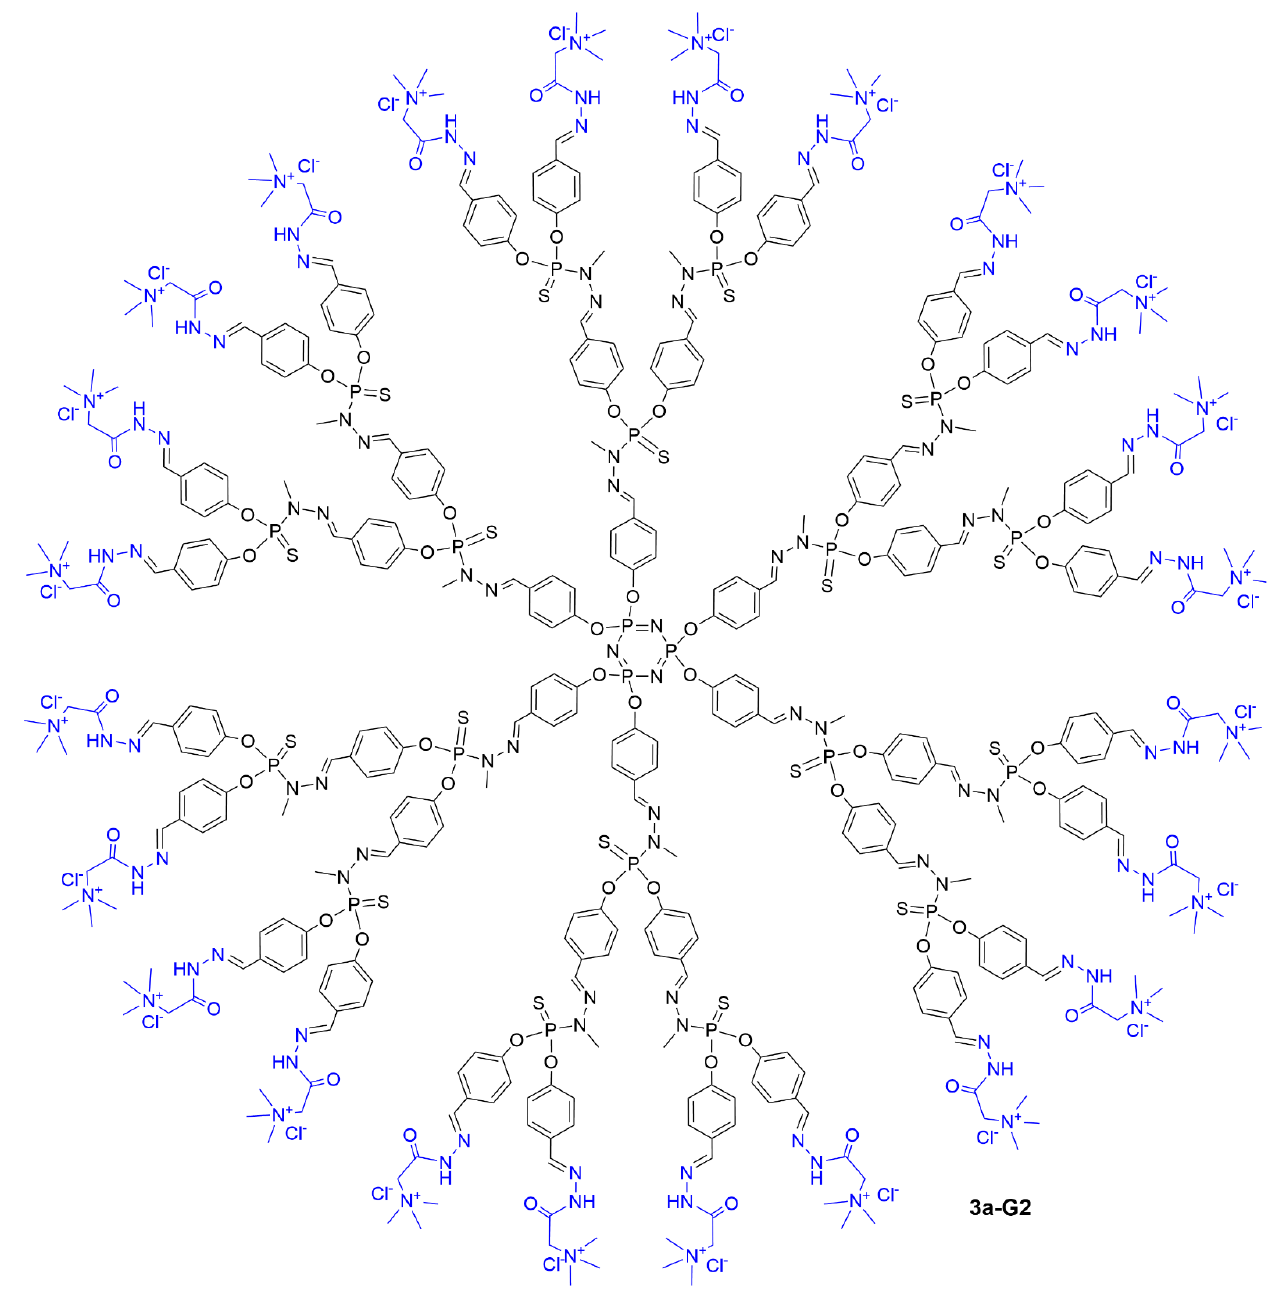
Figure 6. Full chemical structure of dendrimer 3a-G2 .